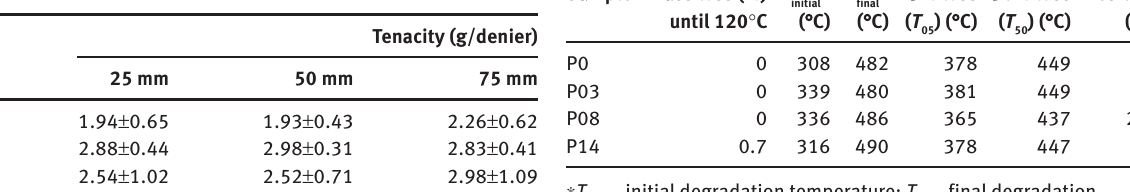
Table 3: Tenacity of the polypropylene filaments at different gauge lengths.